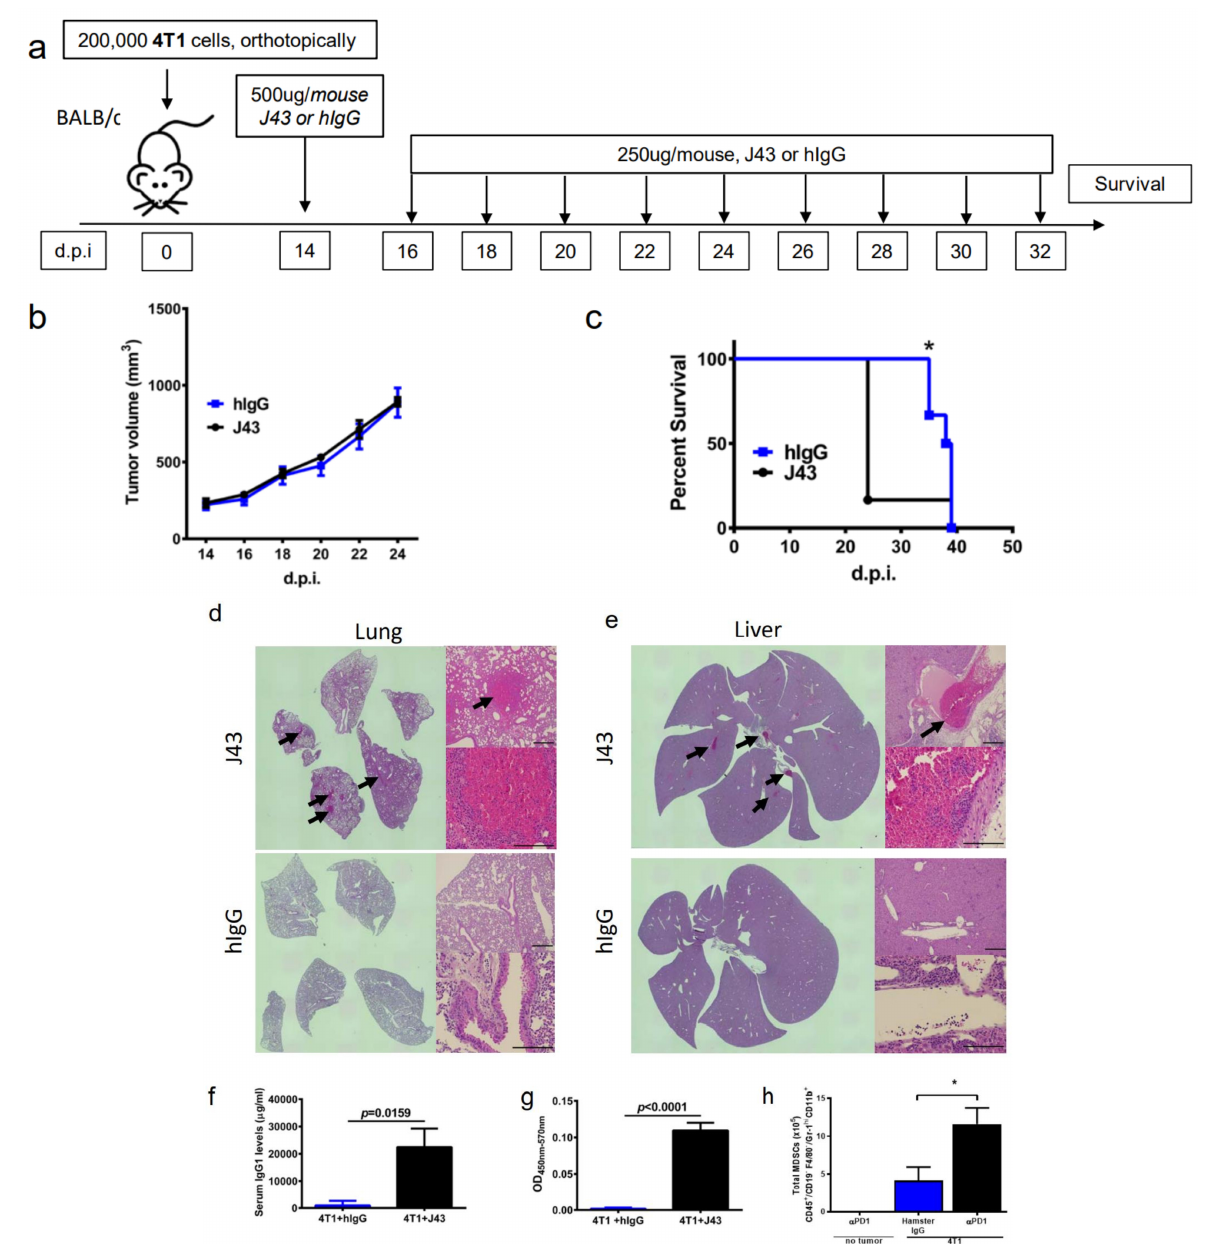
Figure 1. Repeated xenogeneic α programmed cell death 1 (PD-1) administration induced fatal hypersensitivity in the 4T1 breast cancer model. ( a ) Experimental schema: BALB/c mice were inoculated orthotopically with 4T1 breast carcinoma cells in the breast mammary fat pad and administered either hamster anti-mouse isotype (hIgG) or α PD-1 (clone: J43). ( b ) Tumor growth curves of 4T1 in BALB/c mice depicted as mean ± s.e.m. over days post inoculation (d.p.i.). ( c ) Kaplan–Meier survival curves of 4T1-tumor-bearing BALB/c mice treated with either hIgG or J43. Log-rank (Mantel–Cox) test used to compare groups. Representative H&E stains of ( d ) lungs and ( e ) liver of 4T1 mice treated with either hIgG or J43 demonstrating inflammation, loss of normal tissue architecture, and influx of mononuclear cells (black arrows). ( f ) Serum IgG1 levels in mice treated with either hIgG or J43. ( g ) J43 reactive IgG1 levels in the serum of 4T1 tumor-bearing mice treated with either hIgG or J43. ( h ) Absolute numbers of myeloid derived suppressor cells (MDSCs) in the lungs of 4T1 tumor bearing mice as assessed by flow cytometry. Bar graphs represent the mean value and error bars represent the standard error of the mean. * p < 0.05, n = 6 mice per